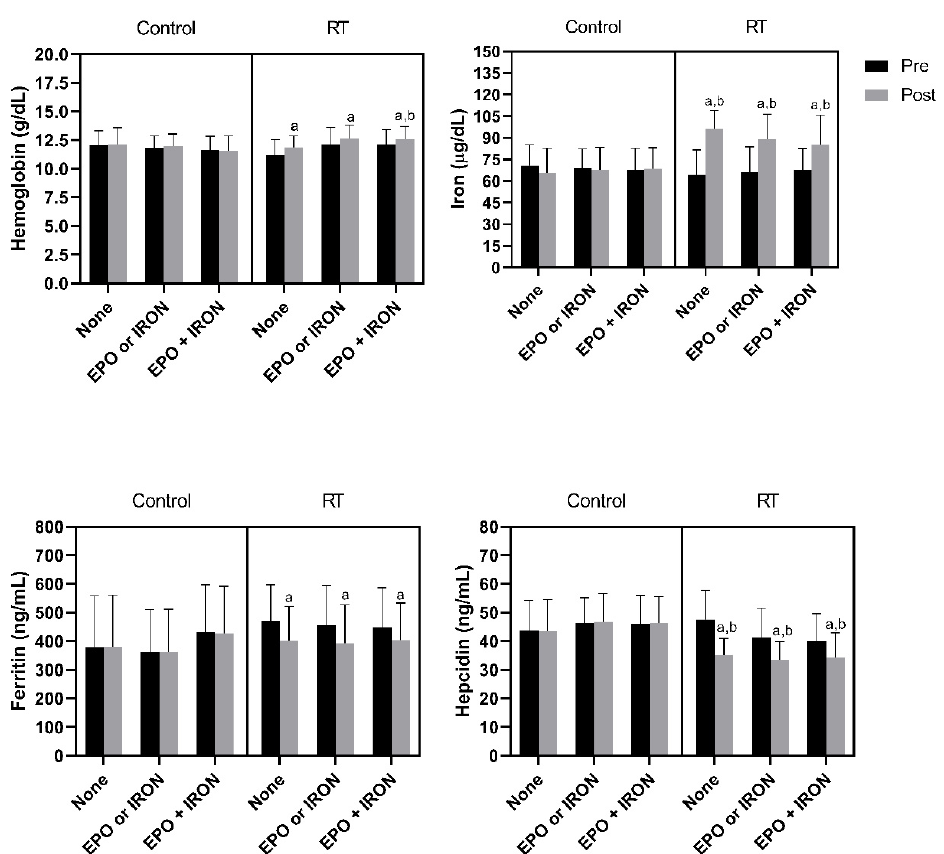
Figure 2. RT modulated iron, hemoglobin, ferritin and hepcidin levels in hemodialysis patients regardless of iron treatment. RT: resistance training; EPO: erythropoietin. Data expressed by mean ± SD. a p < 0.05 in relation to pre (within group and treatment). b p < 0.05 in relation to CTL post (between group and within treatment).